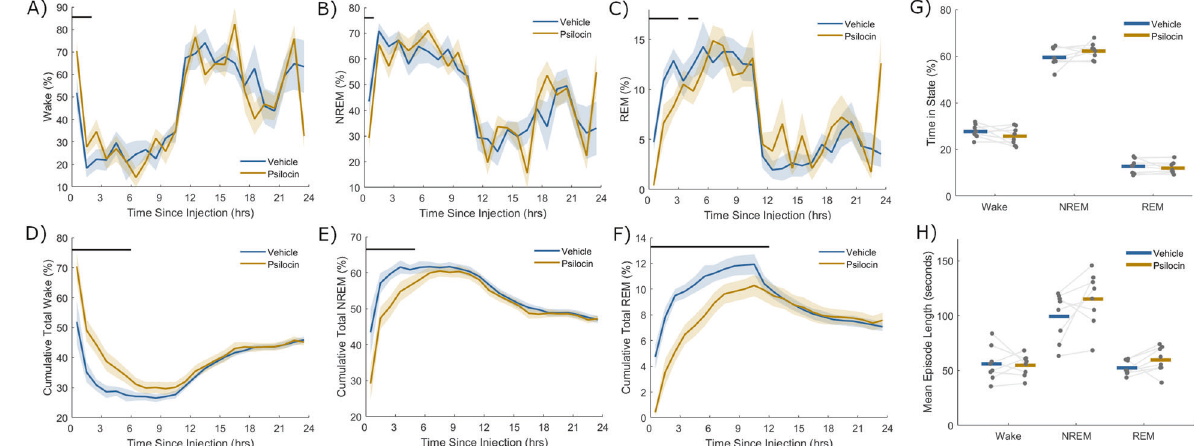
Fig. 3 Sleep-wake architecture over 24 hours following vehicle and psilocin injection. Percentage of time scored as A ) wake, B ) NREM sleep and C ) REM sleep in successive non-overlapping windows of one-hour up to 24 h after injection with vehicle (blue) and psilocin (yellow). The total cumulative percentage of time scored as D ) wake, E ) NREM sleep and F ) REM sleep from injection until up to 24 h after injection with vehicle (blue) and with psilocin (yellow), as a function of time since injection. Note that at each time point cumulative total of wake, cumulative total of NREM sleep and cumulative total of REM sleep will together always sum to 100%. Coloured lines denote the mean and sections the standard error of the mean over all animals. Black lines indicate time points that were signi fi cantly different ( p < 0.05) according to paired t -tests applied at discrete time points. G ) The percentage time from three hours after injection until the end of the light period which was scored as wake, NREM or REM sleep, and H ) the mean length in seconds of wake, NREM and REM sleep episodes in this time. Grey dots correspond to individual animals, with grey lines linking values from the same animal, coloured lines indicate the group mean for vehicle (blue) and psilocin (yellow) function of time since injection over 24 h. These cumulative time courses of wake, NREM and REM sleep (Fig. 3D – F) suggest that homeostasis of vigilance state quantity is restored within one day. From three hours after injection until the end of the light period, the total fraction of time spent in each vigilance state was not signi fi cantly different between psilocin and vehicle conditions (Wake: p = 0.25, NREM: p = 0.24, REM: p = 0.42, n = 8, paired t -test, Fig. 3G). Additionally, the average duration of wake, NREM and REM sleep episodes was unchanged (Wake: p = 0.79, NREM: p = 0.13, REM: p = 0.13, n = 8, paired t -test) (Fig. 3H). Similarly, the quantity of wake, NREM and REM sleep was not different in the dark period after injection (Wake: p = 0.50, NREM: p = 0.92, REM: p = 0.07, n = 4, paired t- test).